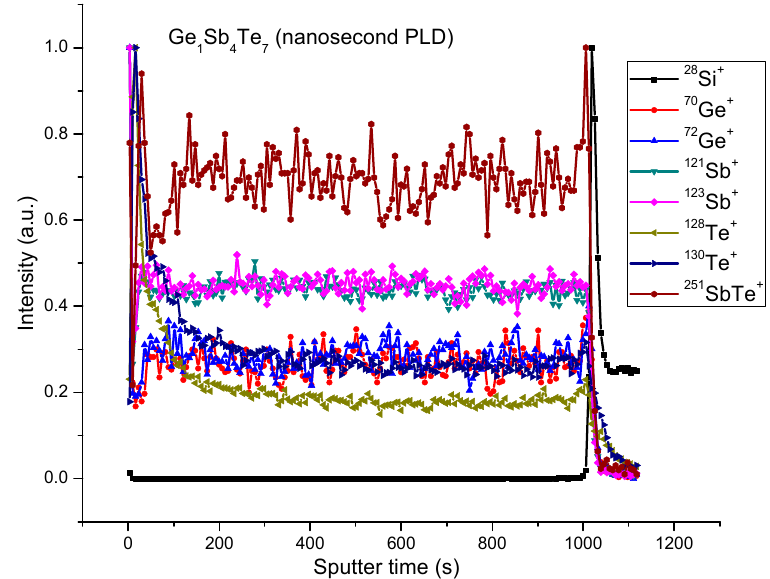
Figure 1. The ToF-SIMS depth profiles obtained in a positive polarity of the Ge 1 Sb 4 Te 7 sample.